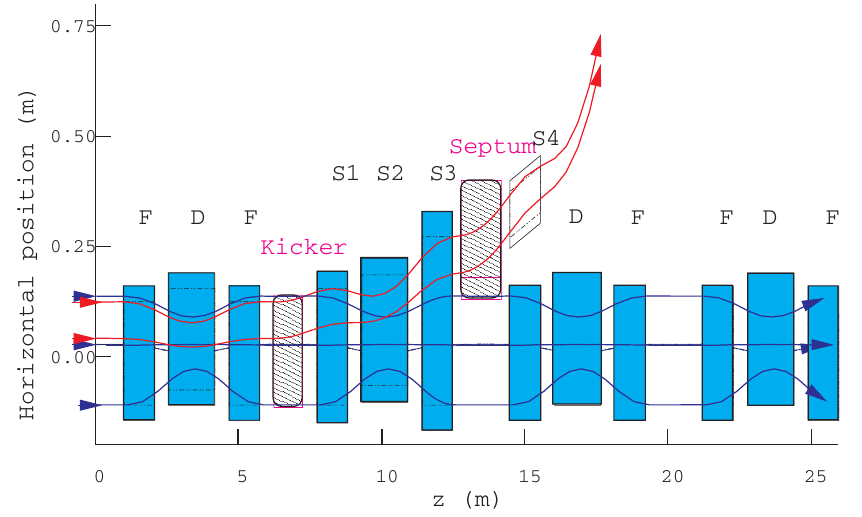
FIG. 30. (Color) Extraction out of the FFAG. S1 to S4 are special extraction region dipoles.